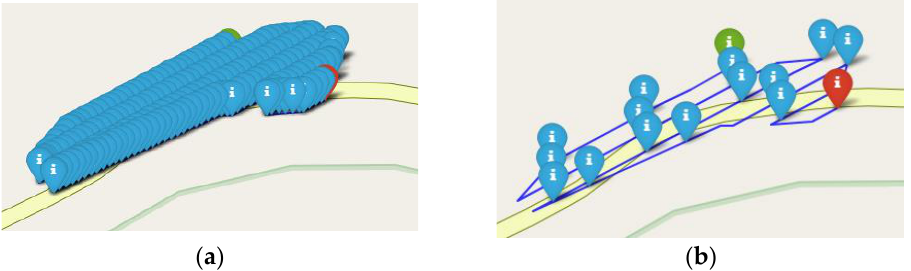
Figure 6. Trajectory interactive visualization. ( a ) Visualization of the total number of points that make up the trajectory; ( b ) visualization of a percentage of points set by the